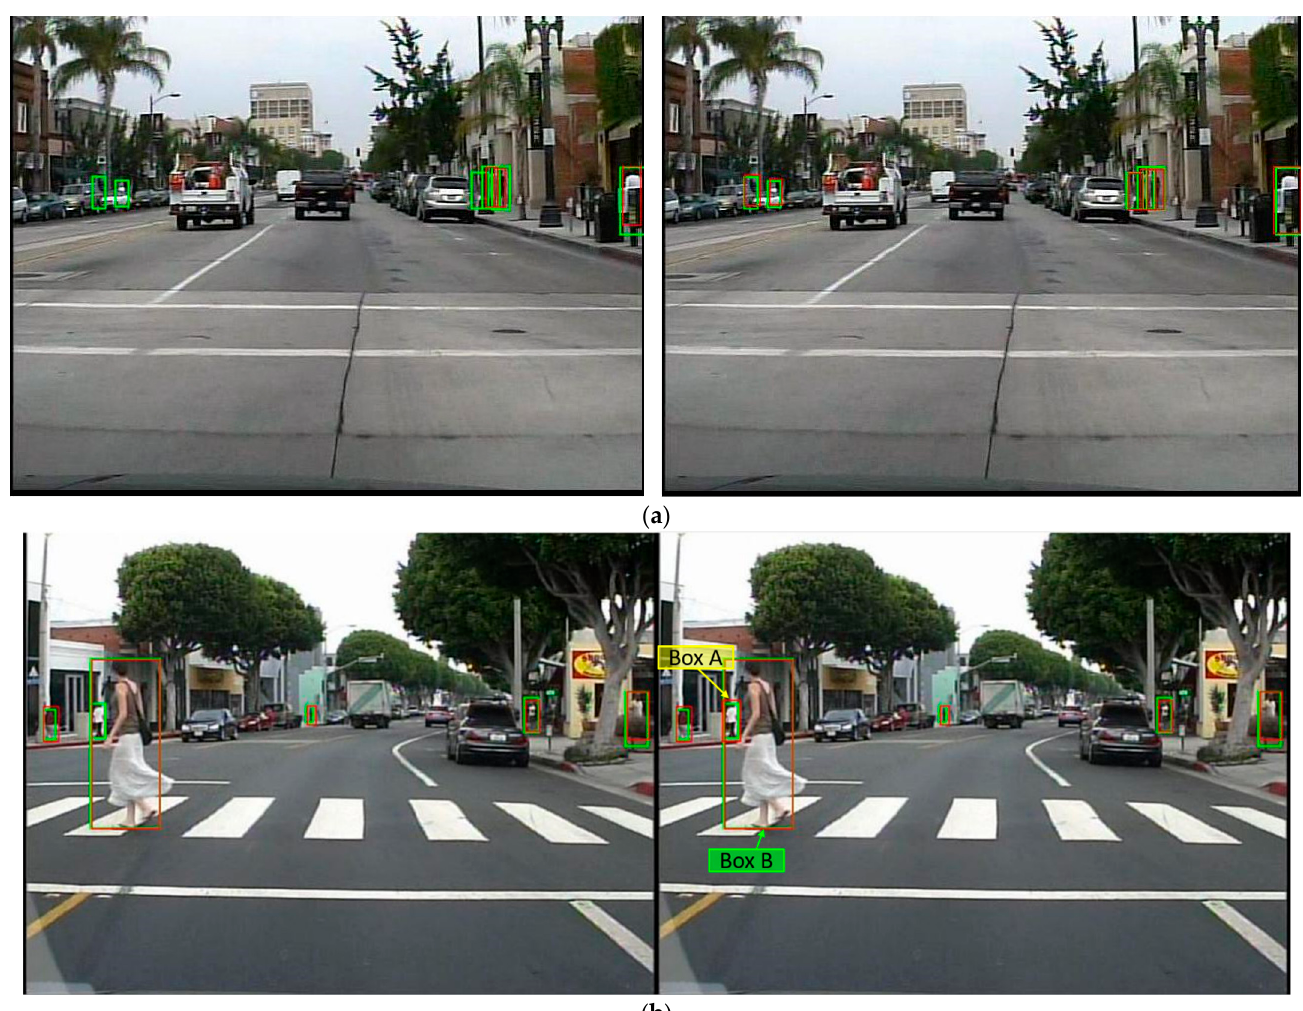
Figure 6. ( a ) Comparison of the detection performance based on the baseline method, cascade R-CNN+FPN. Left, without DCAM and right, with DCAM. ( b ) Detection examples with plain NMS (left) and DIoU-NMS (right). Green boxes, ground truth and red boxes, detection results.